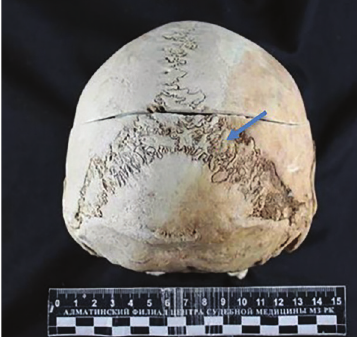
Figure 4 - Skull, back view (the arrow indicates the described